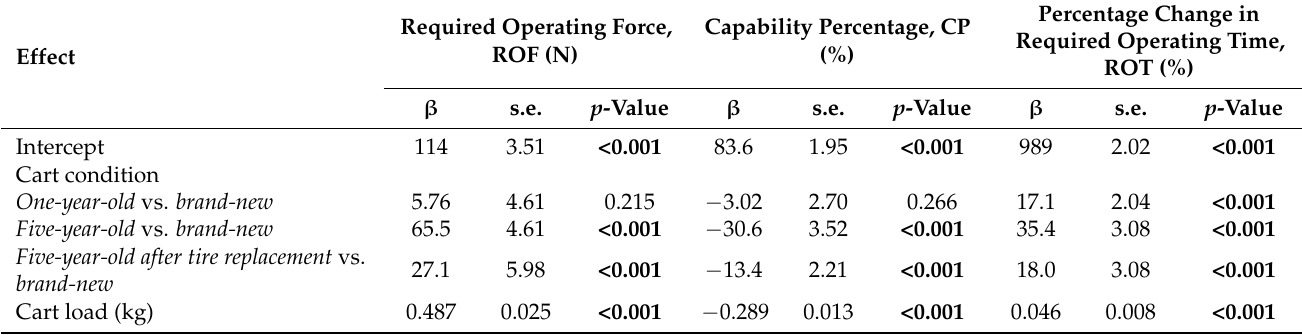
Table 2. Statistical results of Experiment 1a: Regression coefficients ( β ), robust standard errors (s.e.), and p -values from the final models, featuring independent variables: cart condition (brand-new as reference category) and cart load (243 kg as baseline) and dependent variables: ROF, CP, and ROT. Bold fonts indicate p -values are less than our significance level